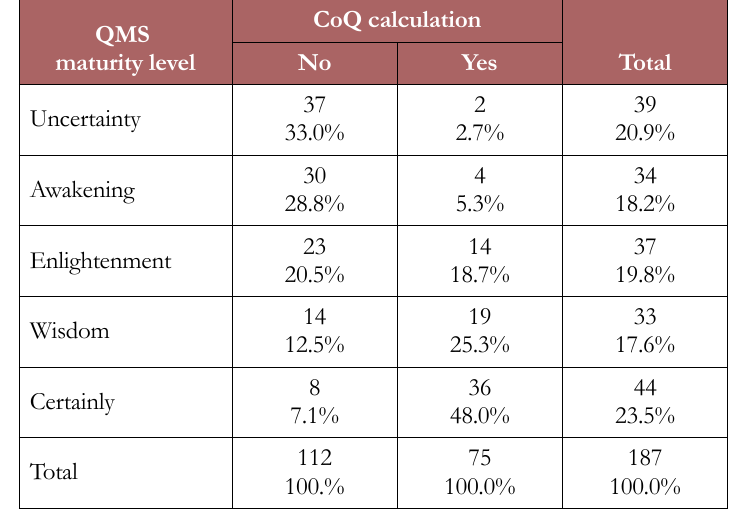
Table 8. QMS Maturity * CoQ calculation